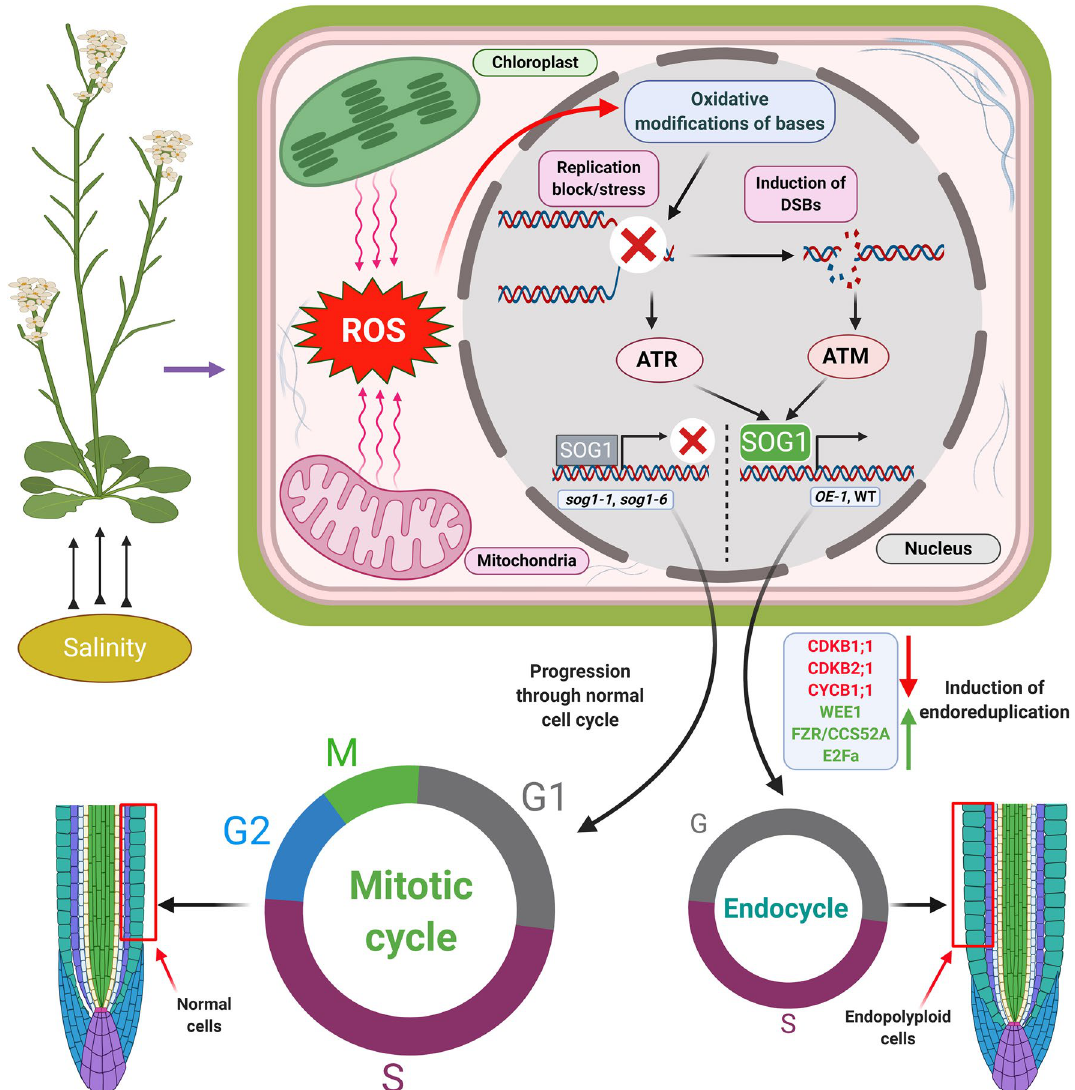
of DSBs. ATR-SOG1 and ATM-SOG1 pathways are activated following replication stress and accumulation of DSBs and regulate the expression of various regulators of cell cycle progression and endoreduplication including, CDKB1;1, CDKB2;1, CYCB1;1, CCS52A, WEE1 and E2Fa, resulting in entry into the endocycle. The figure has been created with